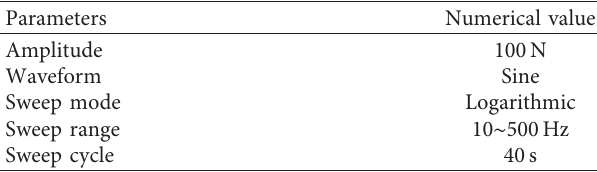
Table 3: Parameters of the excitation signal.